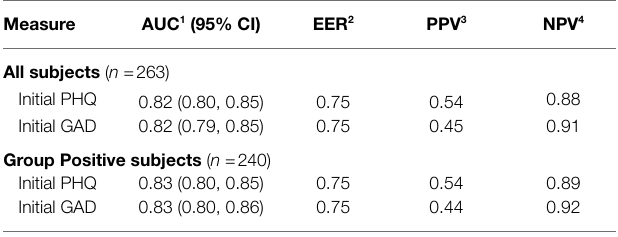
TABLE 8 | Semantic algorithm performance for initial PHQ and GAD scores.